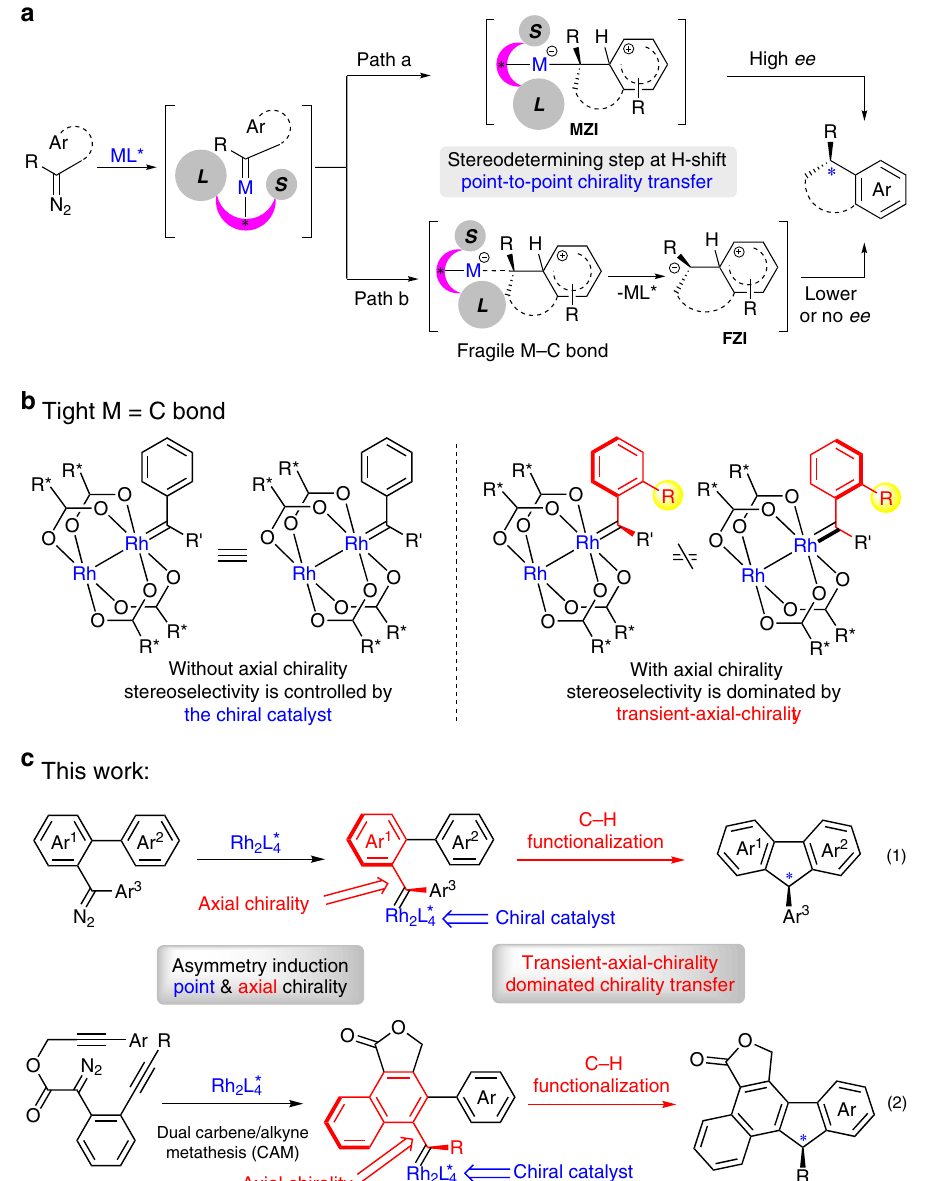
Fig. 1 Asymmetry induction in metal-carbene reactions. a Asymmetry induction in catalytic metal-carbene C(sp 2 )-H functionalization. b Chirality in transient carbene intermediate. c This work describes the transient axial-chirality-controlled asymmetric C(sp 2 ) – H functionalization. The pink crescent = chiral ligand (L = large group, S = small group). M = metal catalyst. Rh 2 L 4 * = chiral dirhodium